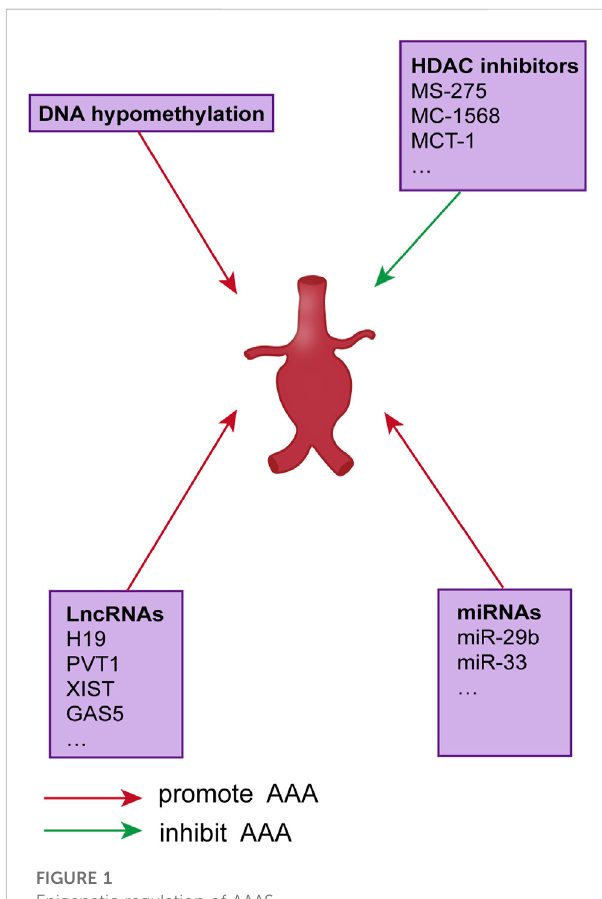
FIGURE 1 Epigenetic regulation of